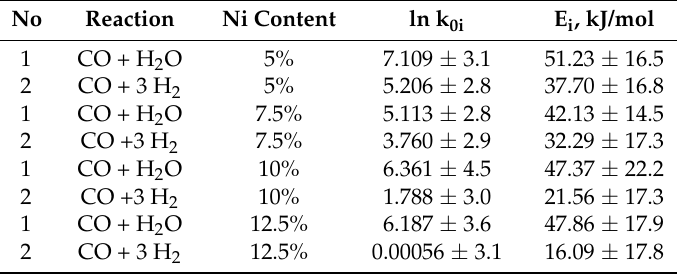
Table 7. Kinetic parameters for catalysts with different Ni loading in the microchannel